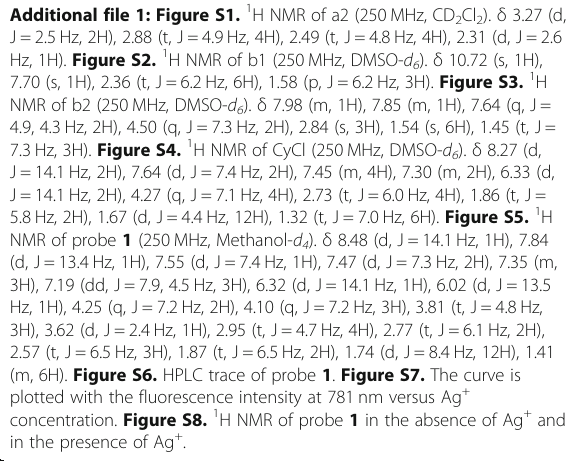
concentration. Figure S8. 1 H NMR of probe 1 in the absence of Ag + and in the presence of Ag + .